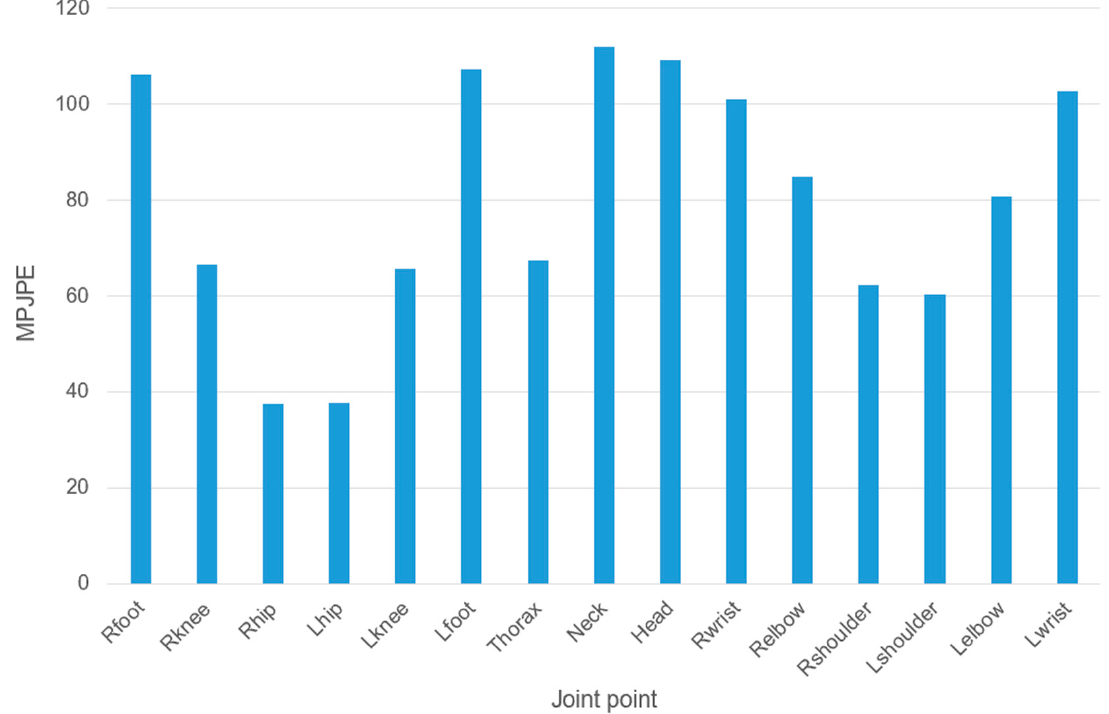
Figure 13. MPJPE for each joint for our method on the Human3.6M dataset.